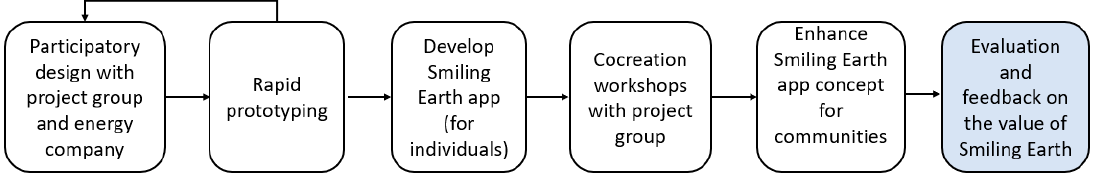
Figure 2. Overall design and evaluation process. The shaded box indicates the evaluation results reported in this paper.